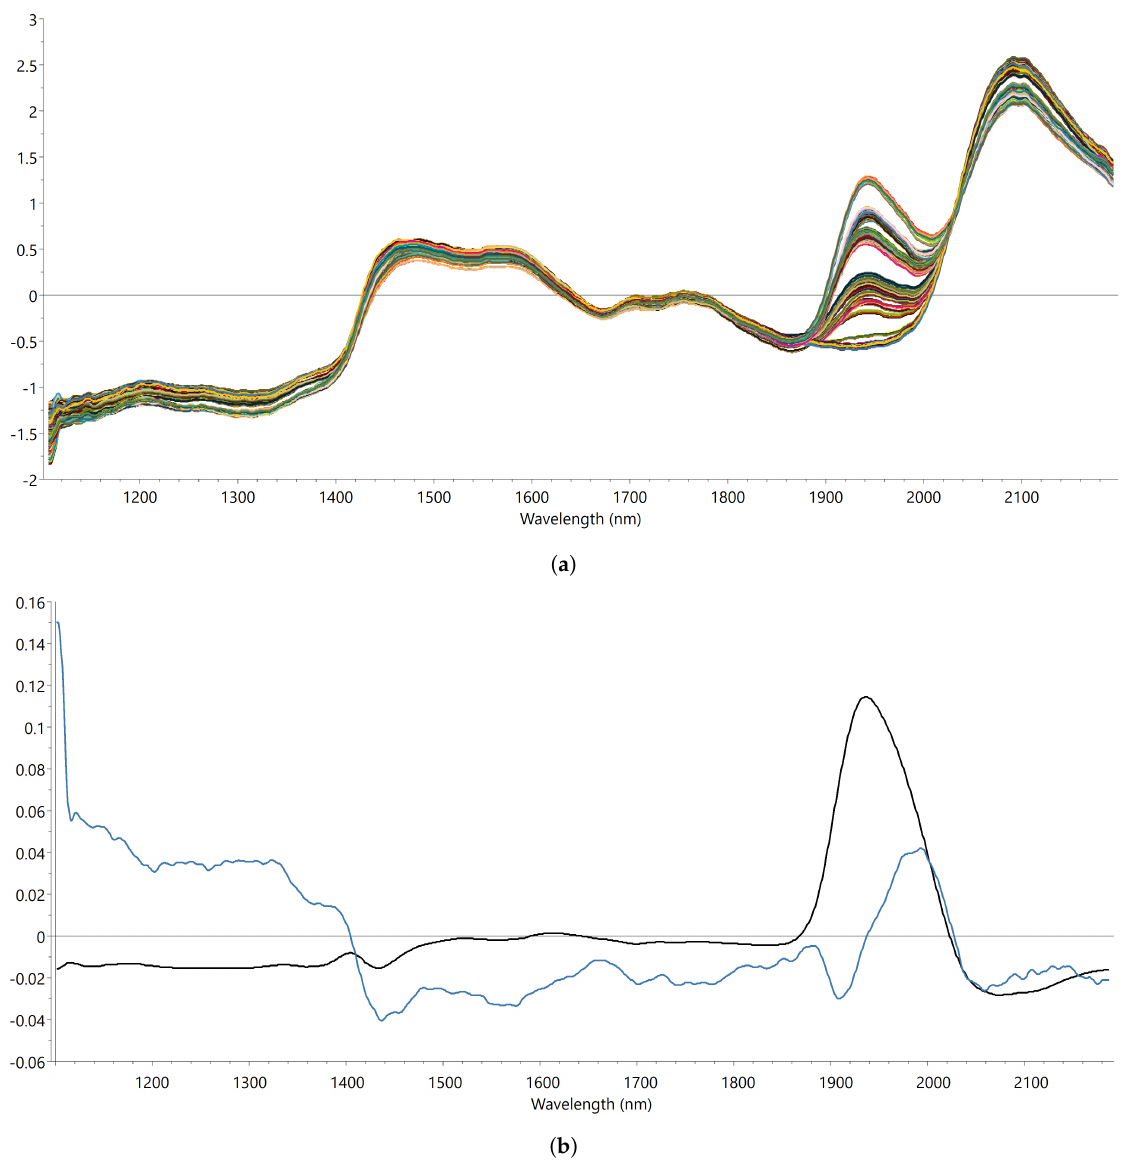
Figure 2. ( a ) SNV-SG filtered spectra (calibration set); ( b ) loadings of PLS calibration model (range 1100–2200 nm); black line (LV1), blue line